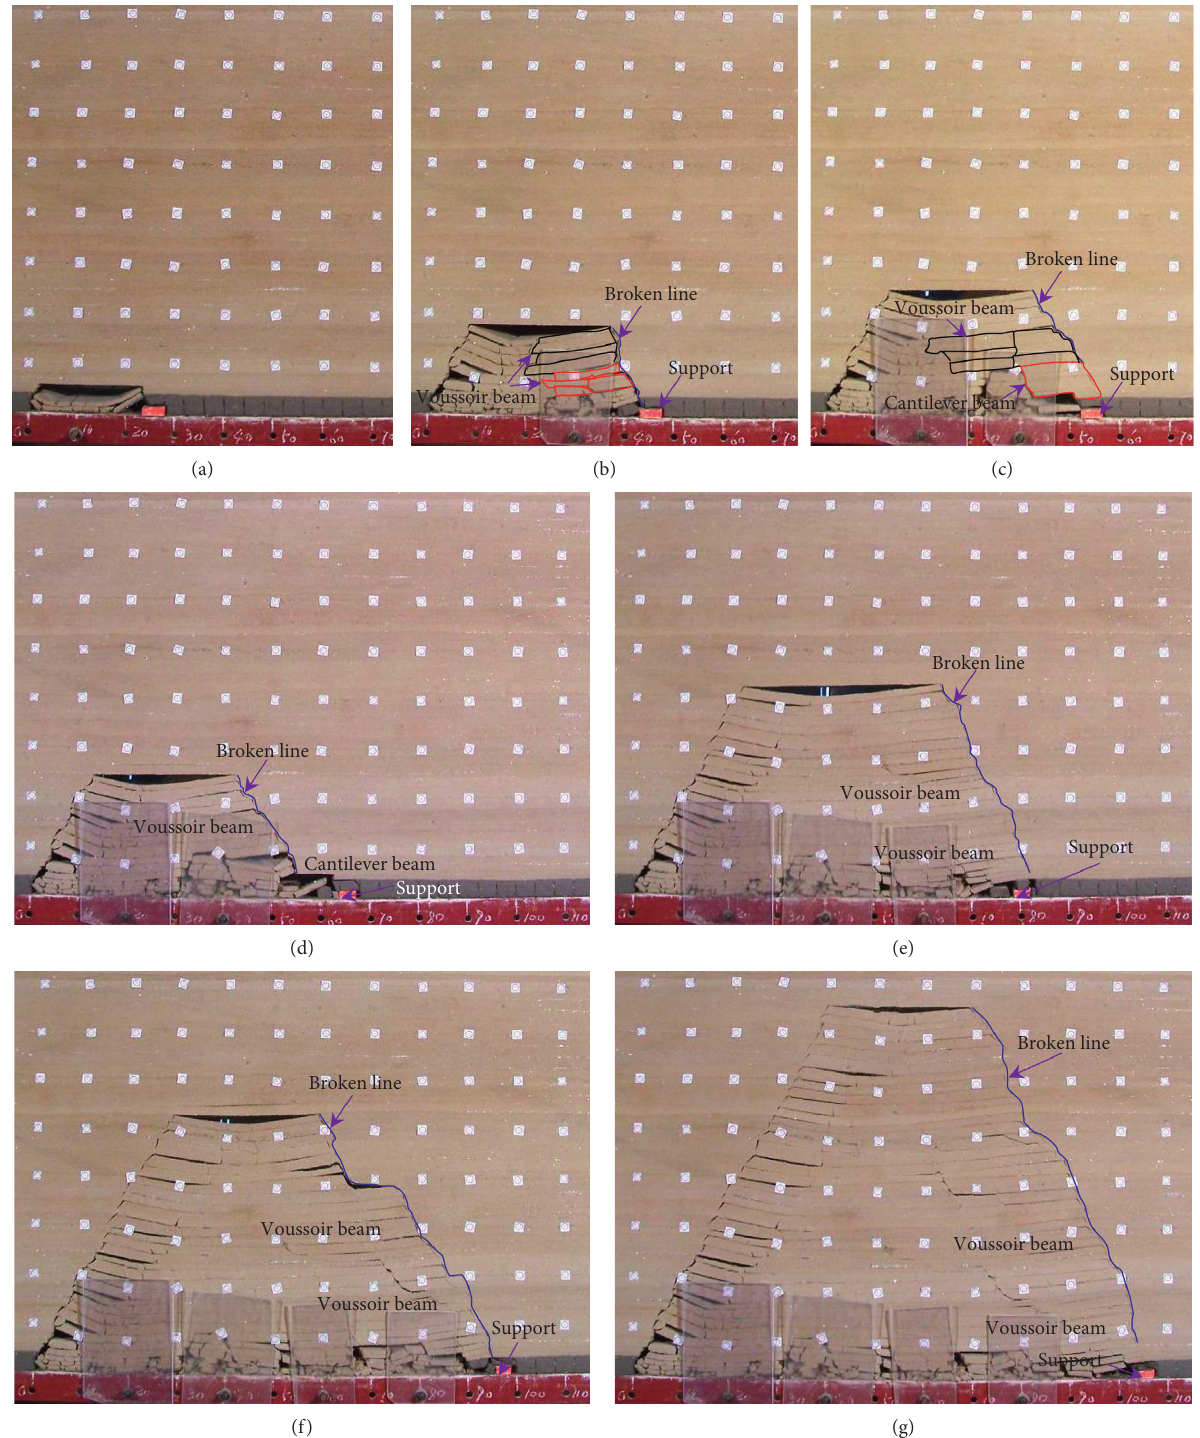
Figure 6: Fracture pattern evolution of roof with the advance of LTCC face. (a) 112m, (b) 192m, (c) 224m, (d) 272m, (e) 336m, (f) 400m, and (g)